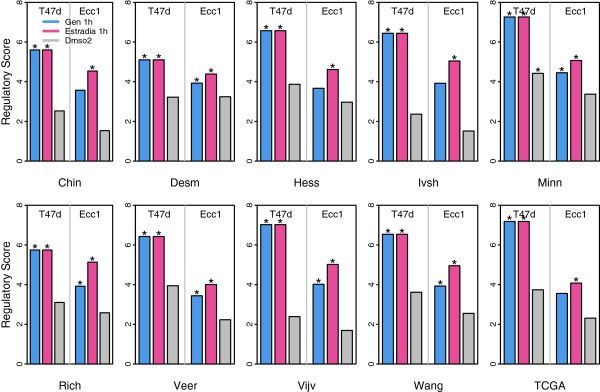
The activity difference of ER alpha between ER+ and ER- samples in all 10 datasets. Six ER alpha binding profiles are from T47d or Ecc1 cell lines, and treated with steroid hormone (Gen and Estradia) for 1h or Dmso2 as control. “*” indicates that a ER alpha binding profile has significantly high activity in ER+ than ER- with P<0.01.